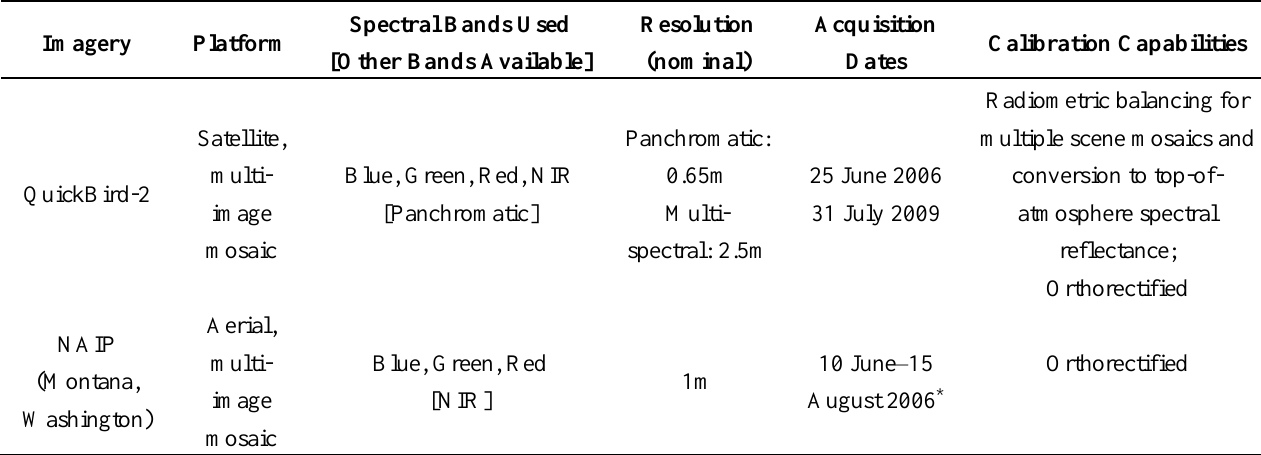
Table 3. Comparison of remotely sensed image